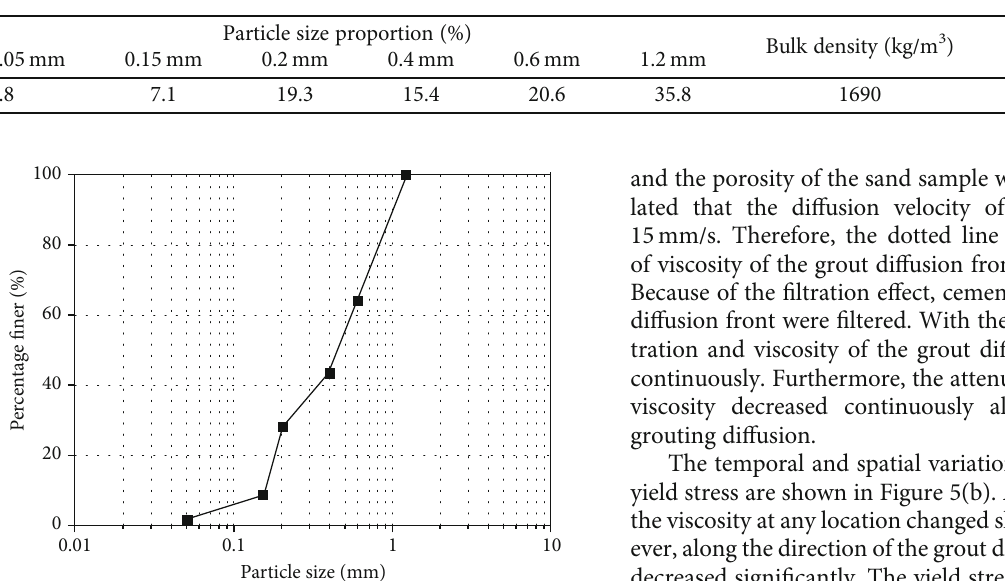
Table 3: Parameters of the grouted medium.